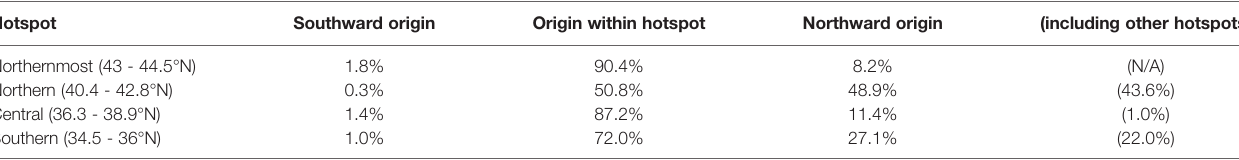
TABLE 3 | Hotspot origin statistics. Hotspot